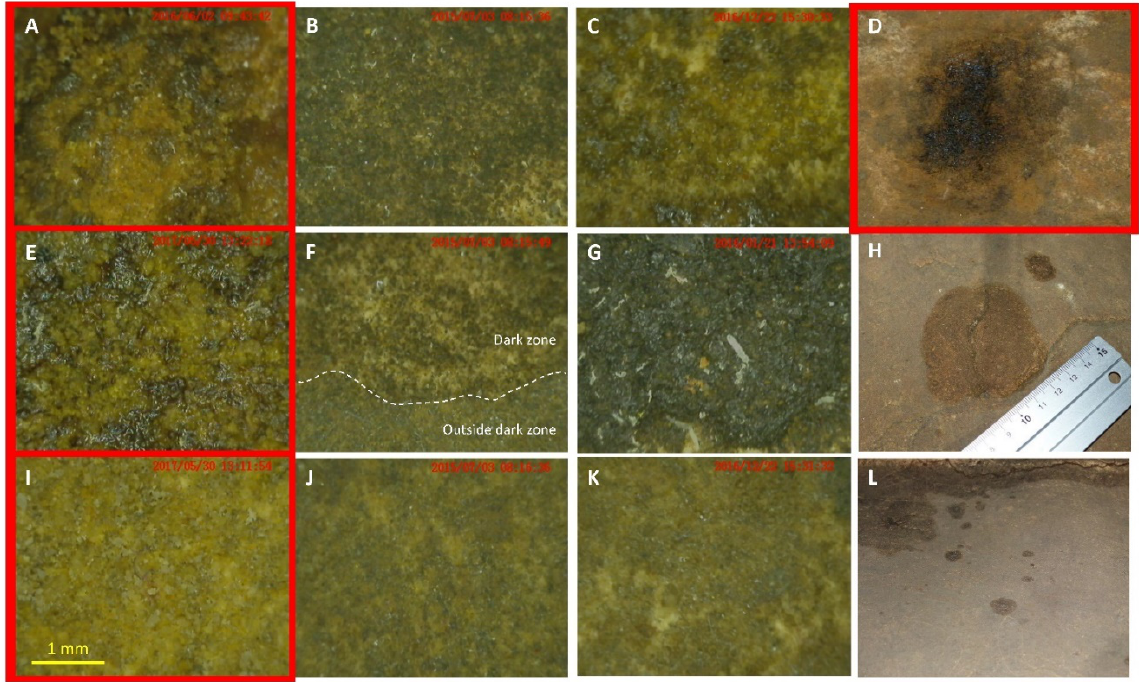
Figure 1. Photographs of dark zones ( H , L ) from the Apse compared with a black stain ( D ), and Dino-Lite microscope photographs of dark zones ( B , C , F , G ) compared with outside parts near dark zones ( J , K ), as well as black stains ( A , E ) and outside parts near a black stain ( I ). The reference situation of Apse black stains is shown in red frames, ( B ). ( F ) (showing the limit of a dark zone) and ( J ) correspond to left wall photographs, and ( C ). ( G ) (showing F. candida collembola) and ( K ) to right wall